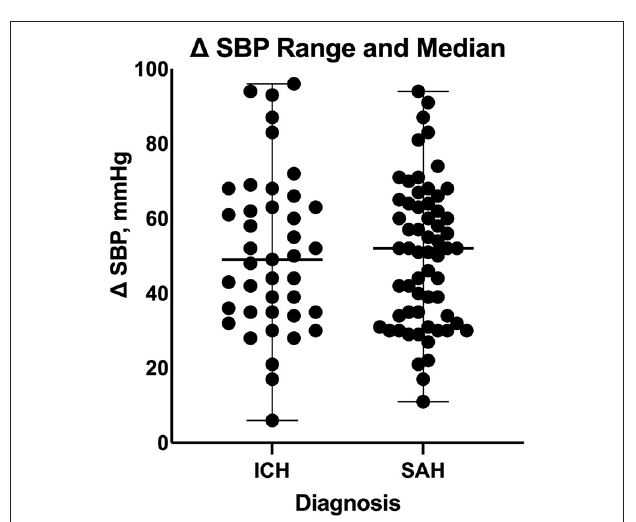
FIGURE 2 | Comparison of systolic blood pressure delta between patients with intracranial hemorrhage and those with subarachnoid hemorrhage during the transition process. ICH, intracranial hemorrhage; SAH, subarachnoid hemorrhage; SBP, systolic blood pressure.